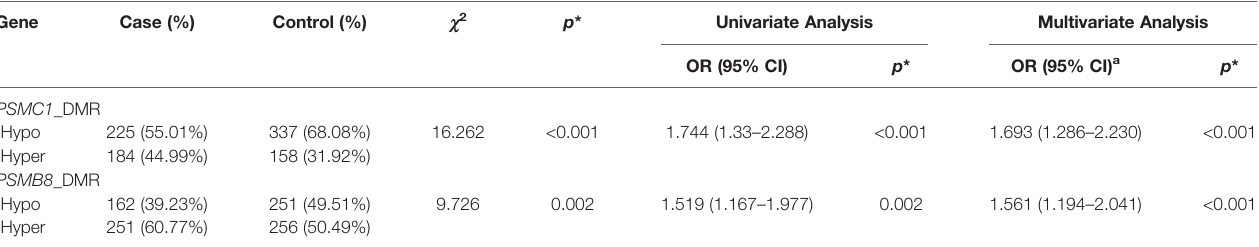
TABLE 4 | The association between weighted methylation levels of PSMC1 and PSMB8 region and BC